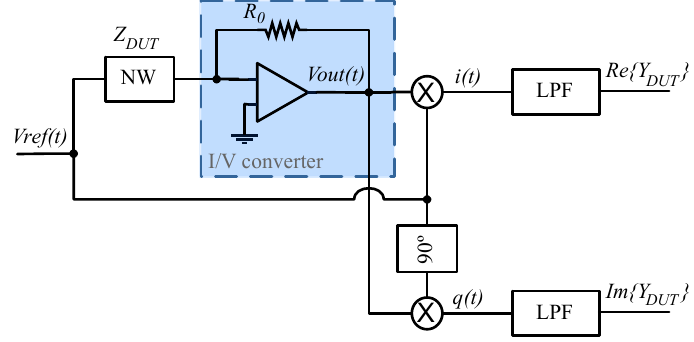
Figure 5. Scheme describing a lock-in technique.